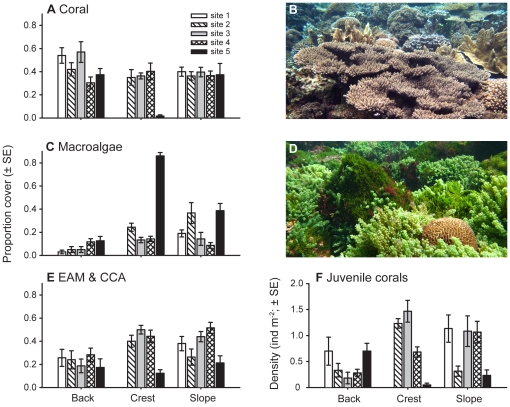
Spatial variation in benthic assemblages on Lord Howe Island.Variation in the (A) cover of live scleractinian coral, (C) cover of macroalgae, (E) cover of the crustose coralline algae (CCA) and epilithic algal matrix (EAM), and (F) density of juvenile corals (<50 mm diameter) among three habitats and five sites on Lord Howe Island. Each mean is based on six transects. (B) A diverse coral-dominated assemblage in the back reef at site 3 on Lord Howe Island, (photo A.H. Baird) and (D) a macroalgal-dominated assemblage on the reef crest at the site 5, the southernmost site. High cover of Caulerpa racemosa and C. taxifolia surrounding small faviid colony.